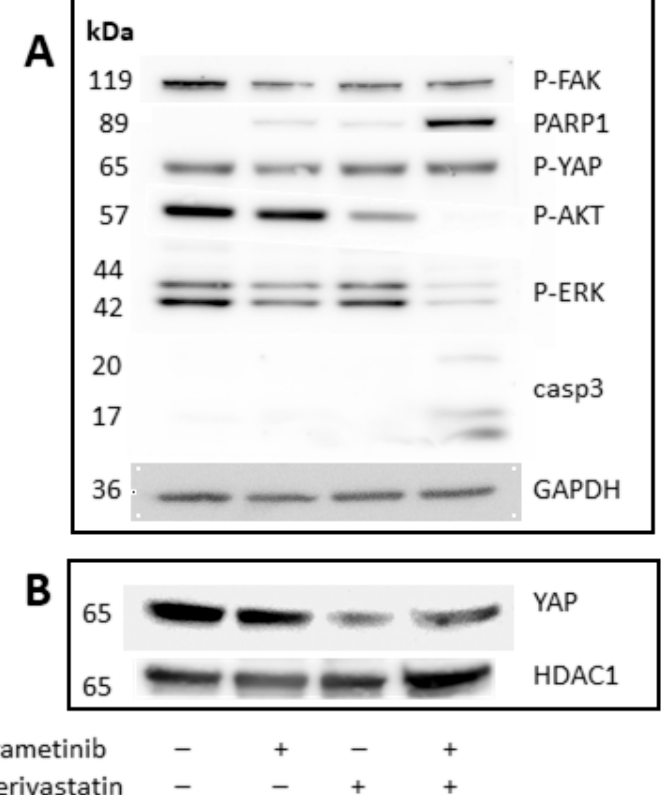
Figure 4. Western blot analysis of cytoplasmic ( A ) and nuclear ( B ) protein extracts of UPMM3 treated with no drug, with trametinib at the synergistic dose of 10 nM, cerivastatin at the synergistic dose of 0.125 µM and with the combination of trametinib and cerivastatin, for 24 h. GAPDH and HDAC1 are the loading controls for cytoplasmic and nuclear extracts,